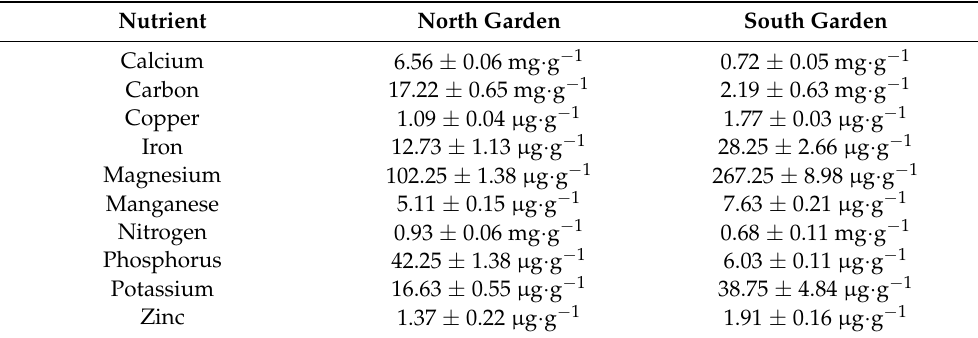
Table 2. The concentration of plant nutrients in soils from north and south Guam gardens used to grow Cycas micronesica plants. Mean ± standard error, n = 4.